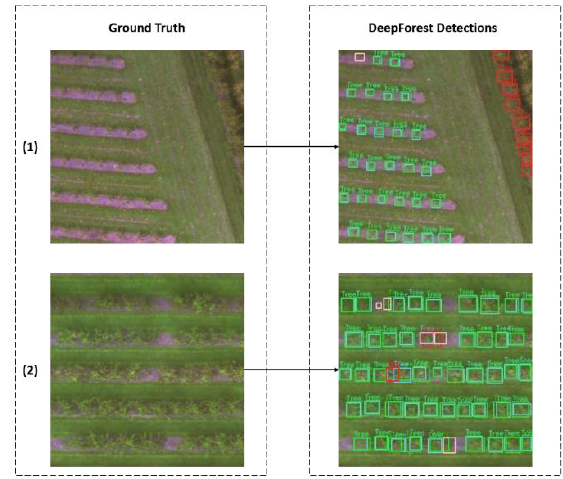
Figure 11. Comparison between the manually detected and DeepForest -based trees on the RGB patches. Red rectangles correspond to false detections (FP), purple rectangles correspond to DeepForest missed detections (FN), blue rectangles correspond to correctly detected trees (TP).